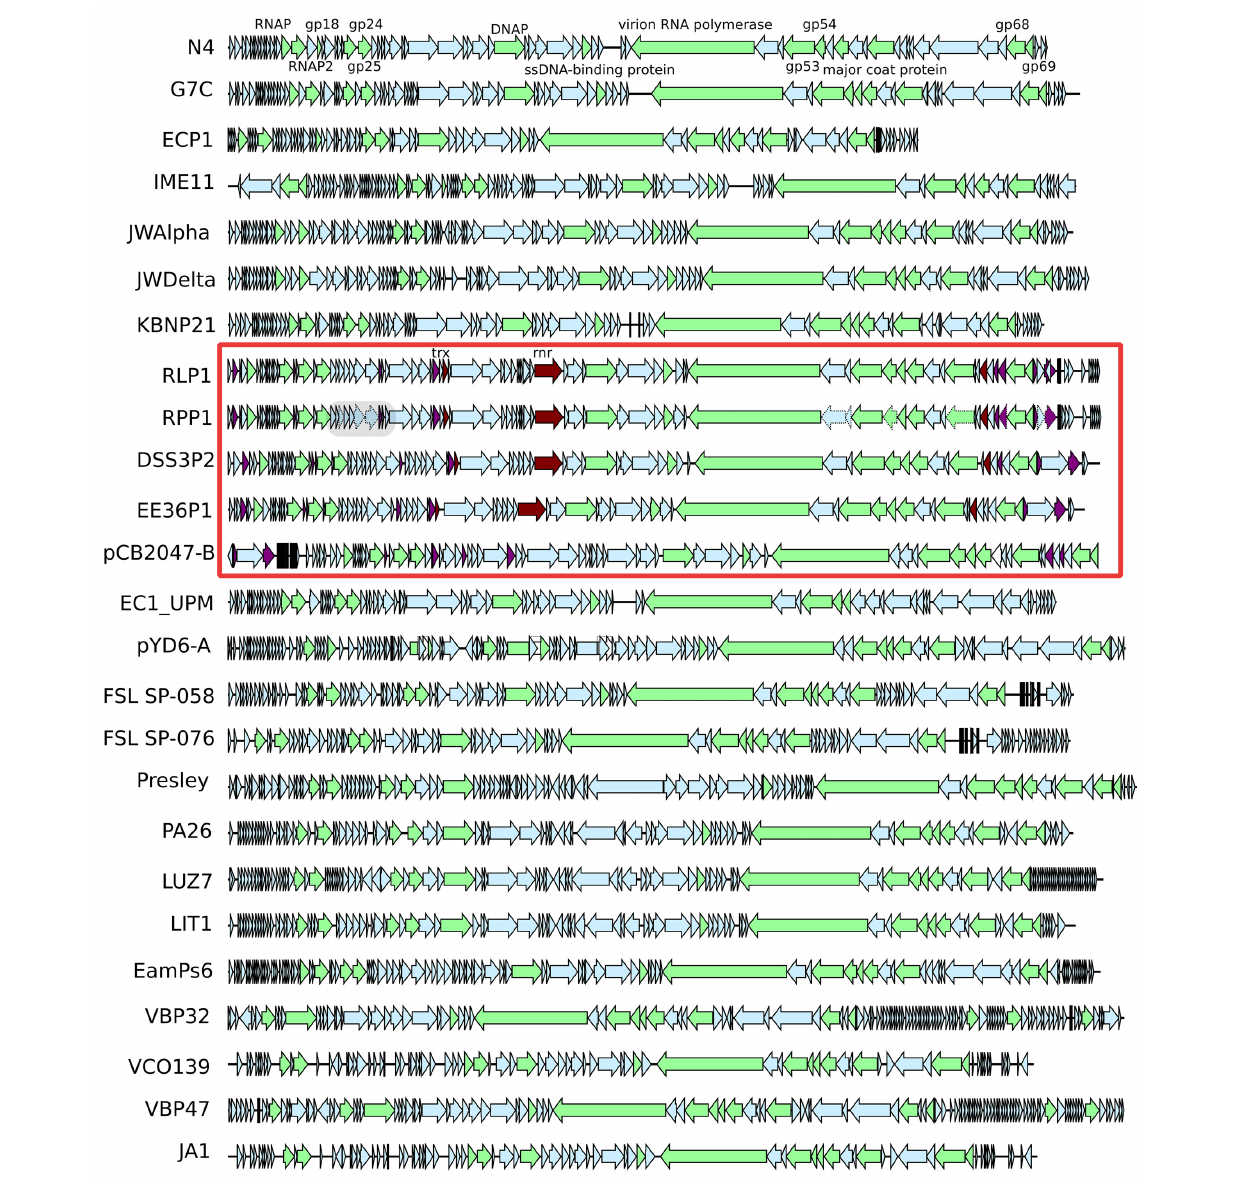
structural genes are outlined by dotted lines. The gray box in RPP1 marks the putative second structural module containing experimentally identified virion proteins. The genomes of RLP1 and RPP1 were deposited with EMBL under accession numbers FR682616 and FR719956,